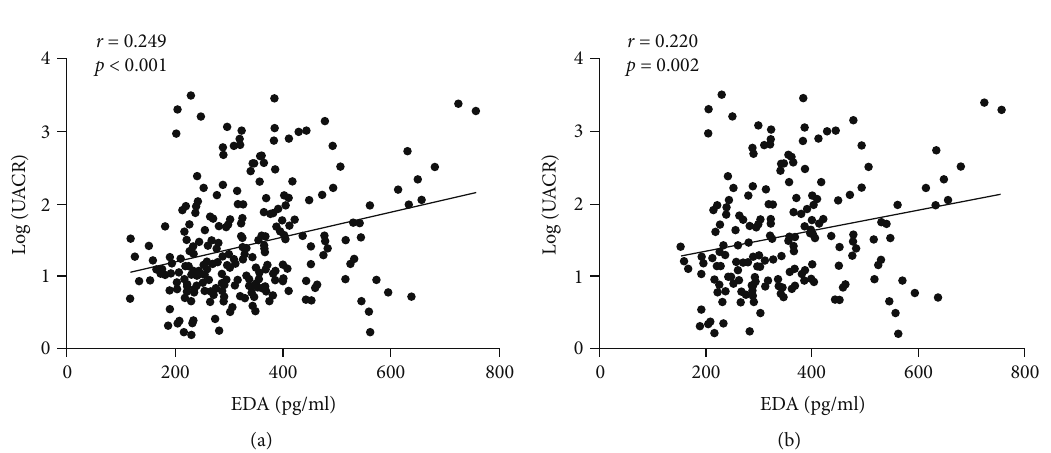
Figure 2: Correlation between serum EDA levels and UACR levels in subjects. (a). Correlation between serum EDA levels and UACR levels in all subjects ( r = 0 : 249 , P < 0 : 001 ). (b). Correlation between serum EDA level and UACR level in T2DM patients ( r = 0 : 220 , P = 0 : 002 ). The logarithm-transformed values of UACR are used for analysis. ( r = 0 : 703 , P < 0 : 001